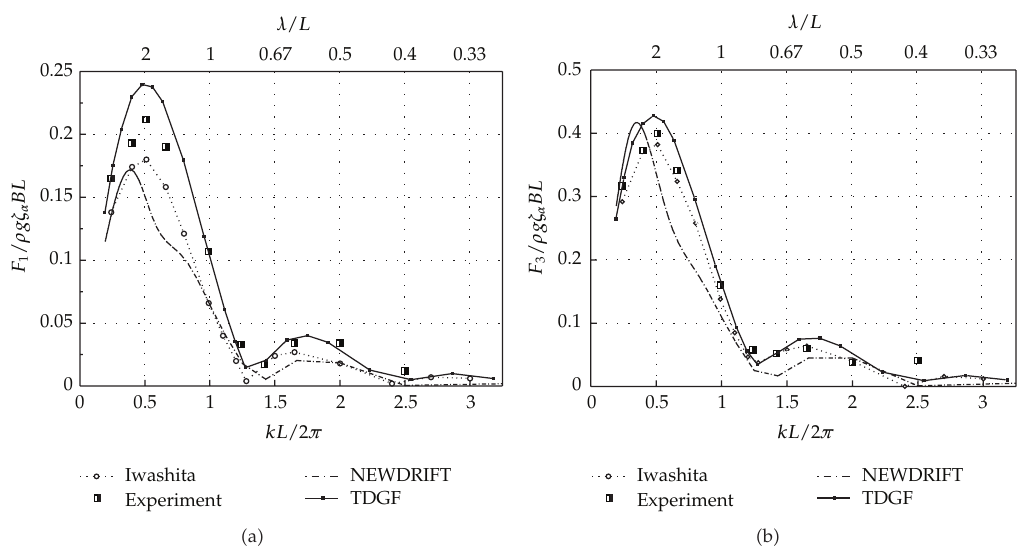
Figure 4: Amplitudes of the wave exciting forces in longitudinal and vertical direction in head seas: F n (cid:7) 0 . 2.